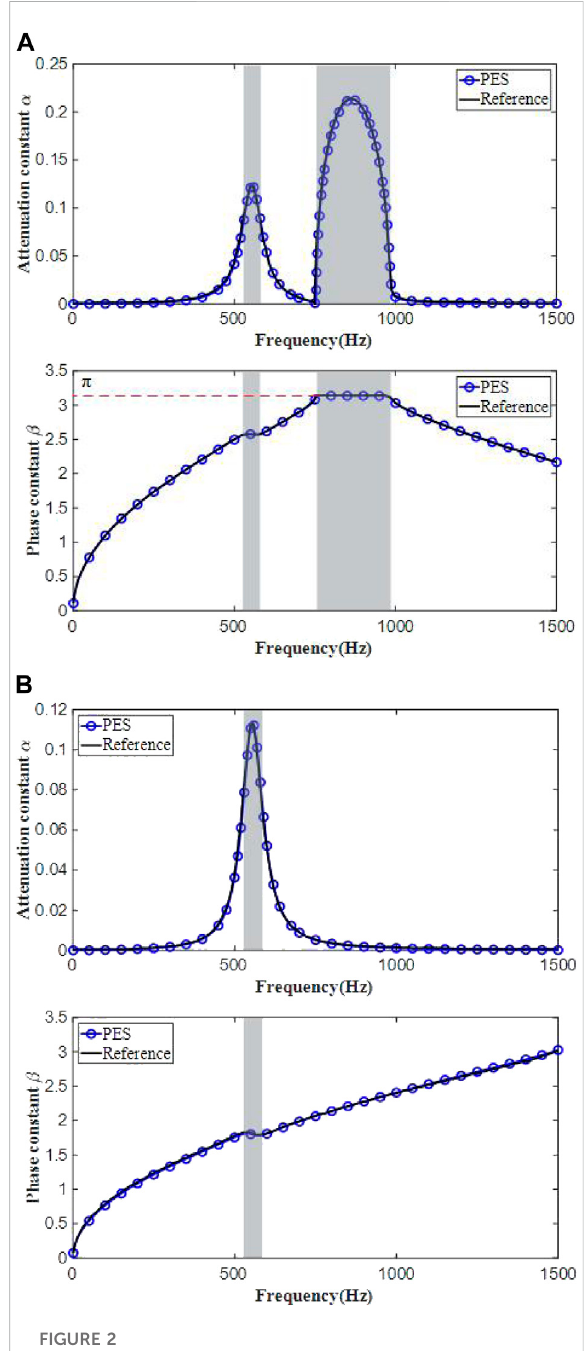
FIGURE 2 Variations in propagation constant with frequency at: (A) θ = 0; (B) θ = π